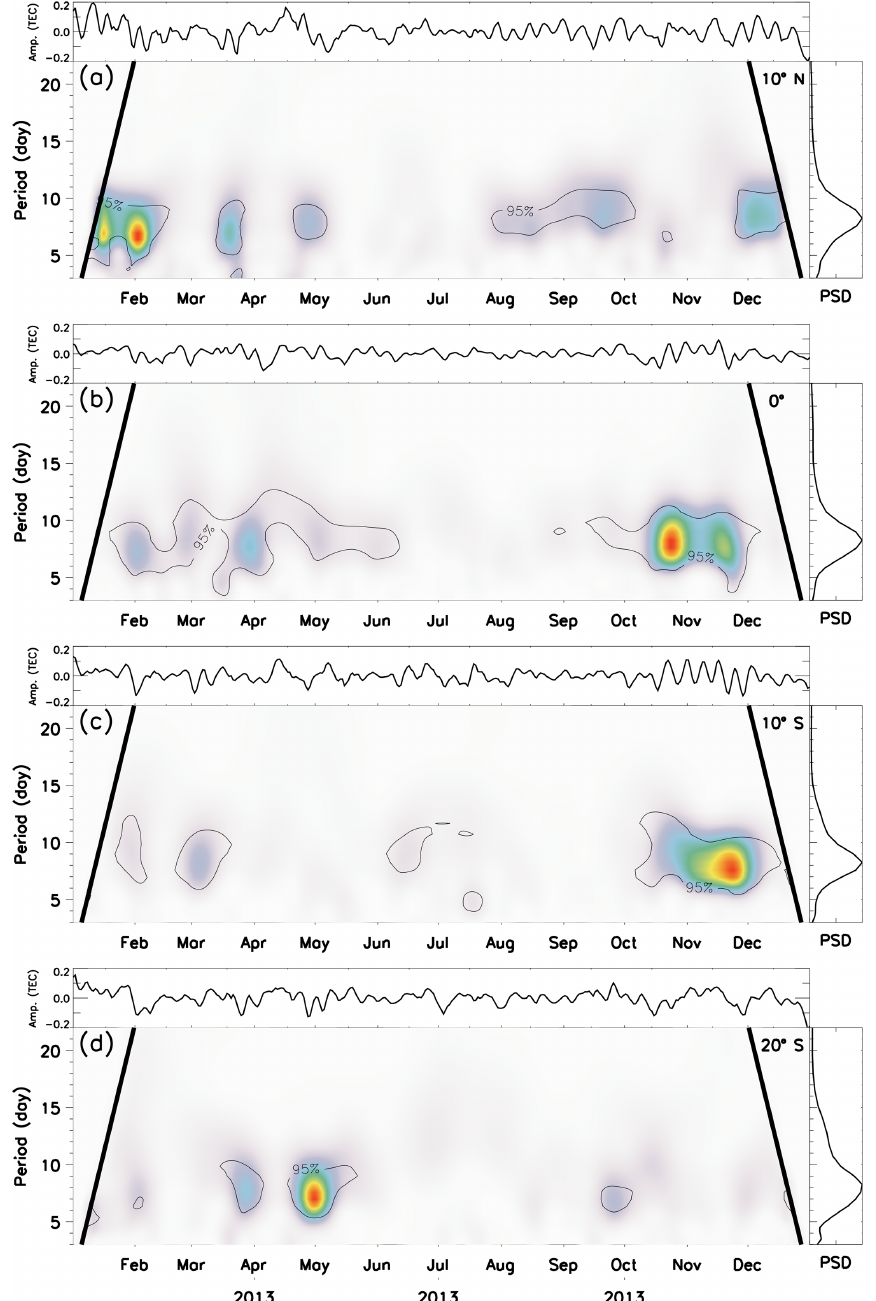
Figure 8. Same as Fig. 5 but for